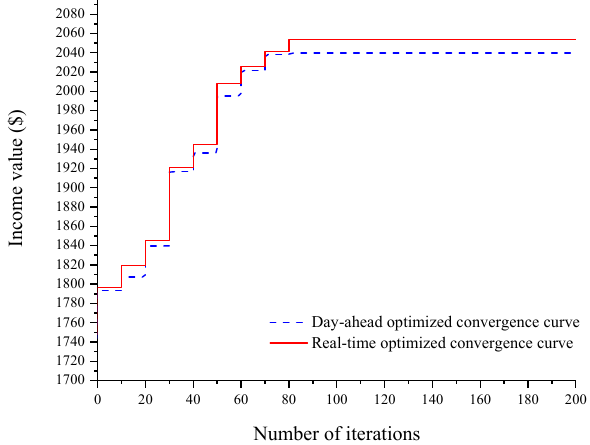
Figure 4. The scheduling revenue convergence curve of the microgrid.